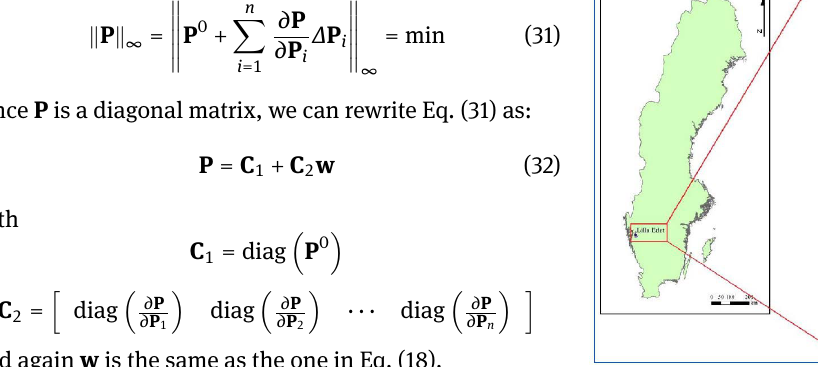
Figure 1: Study area and GPS Reference and observation